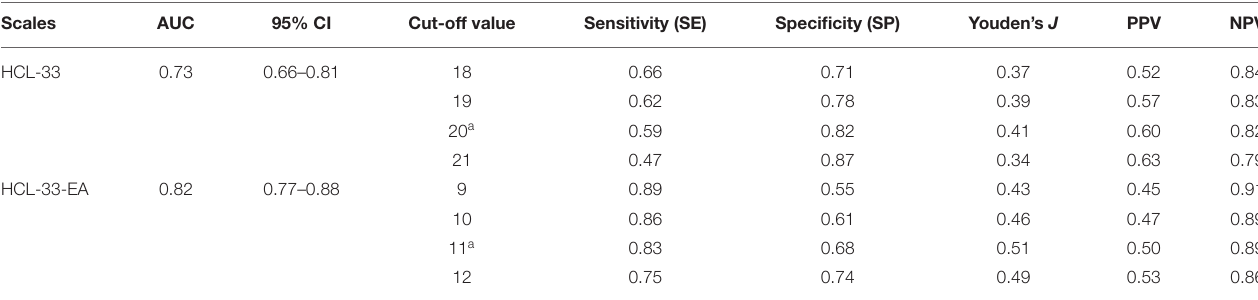
TABLE 2 | Comparison between the HCL-33 and the HCL-33-EA in terms of sensitivity, specificity, PPV, NPV, and Area Under the Curve (AUC) for the detection of bipolar disorder from major depressive disorder. Scales AUC 95%